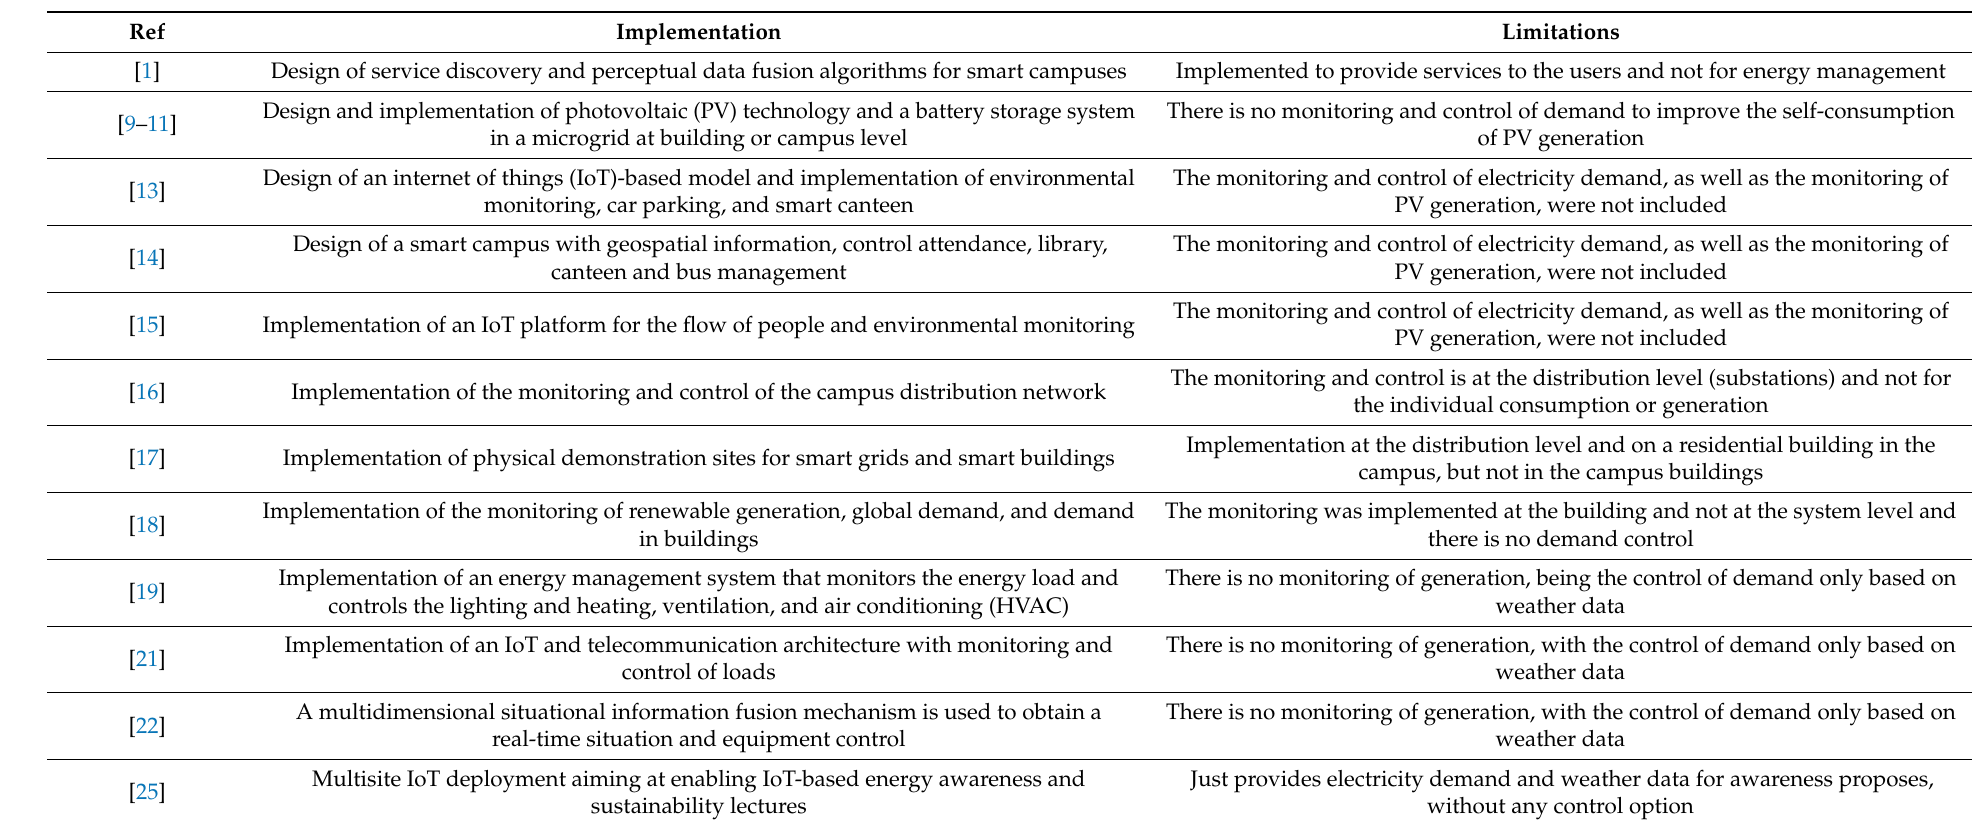
Table 1. Comparison of main implementations in the